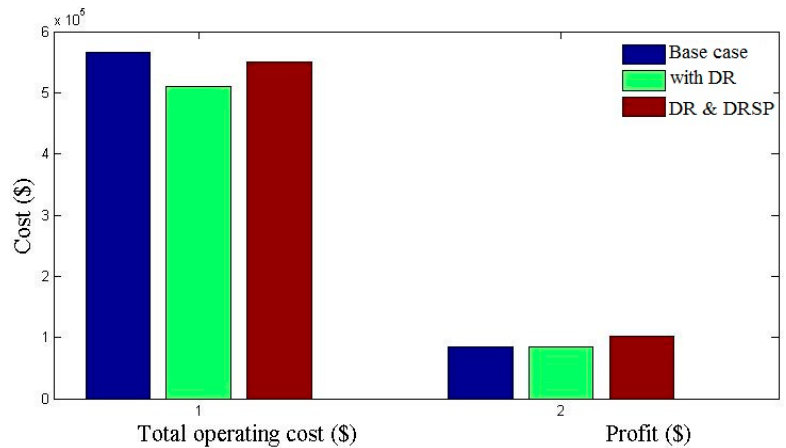
Energies 2017 , 10 , 1465 Figure 4. Cost comparison for TUC, TUC using DR and DRUC. Figure 4. Cost comparison for TUC, TUC using DR and DRUC.